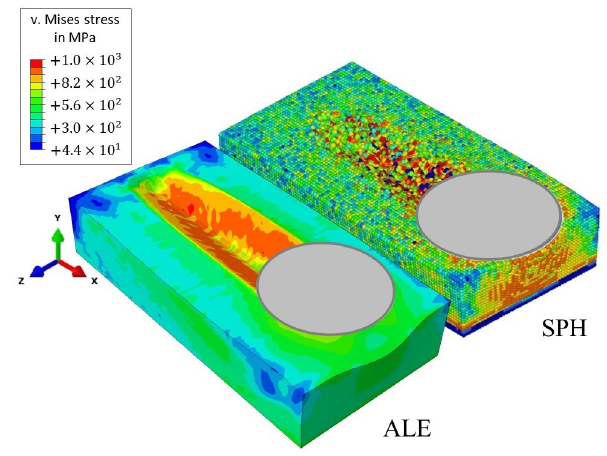
Figure 12. Distribution of the von Mises stress in the ALE and SPH models.